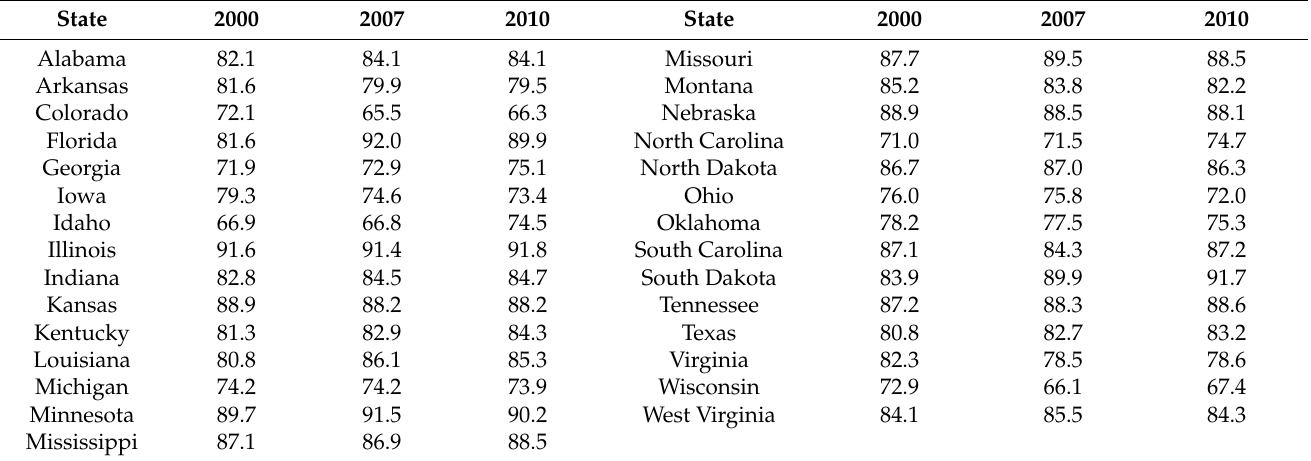
Table 5. Percentage variance explained by log–log regressions (power laws) between population numbers and total entrepreneurship of the county groups of 29 U.S. states.